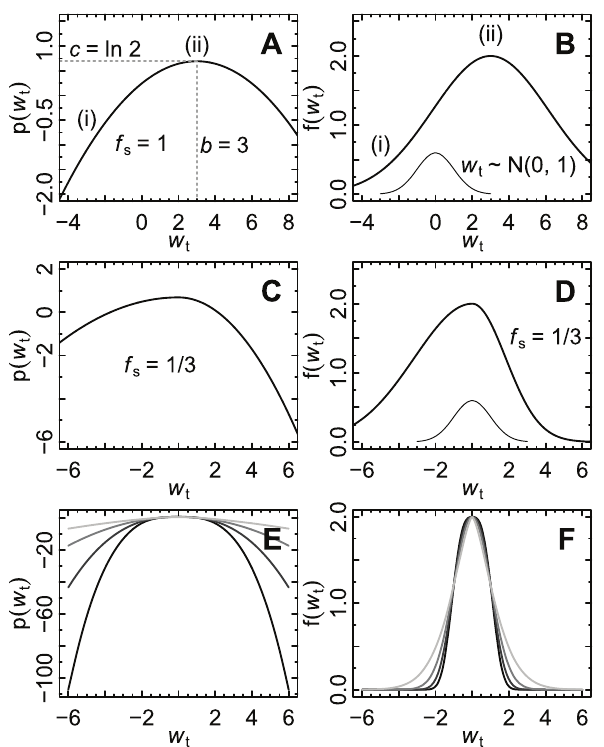
Figure 1. Example log and linear response functions. In the model considered, the response function is the relationship l t ~ f ( w t ) between the net growth rate, l t , at time t , and the environment, w t , at time t . In this figure, we indicate the flexibility of our parameterization of f (see main text for details). A log response function p ( w t ) (A) and corresponding linear-scale response function f ( w t ) (B) for a ~ 2 , a 1 ~ a 2 ~{ 0 : 05 , b ~ 3 , and c ~ ln2 . Region (i) represents a suboptimal environment and region (ii) represents an optimal environment. An example is also shown for an asymmetric response function with f s ~ 1 = 3 ( a 1 ~{ 0 : 05 , a 2 ~{ 0 : 15 ) on the log (C) and linear (D) scales, for b ~ 0 , c ~ ln2 , and a ~ 2 . Standard normal distributions (B, D) represent the population’s local environment w t . In B, the population is in a suboptimal environment, for instance at the periphery of the species’ range. In D the population is close to its ideal environment. Response functions on the linear (E) and log (F) scales for different values of a , ranging from a ~ 1 : 5 for the light grey, to a ~ 3 for the black line, for f s ~ 1 , and a 1 ~ a 2 ~{ 0 : 5 . The intermediate values of a are 2 and 2.5. value of w t at which f is maximized. The rate of falloff of p as w t decreases (respectively, increases) from the ideal environment is controlled by a 1 (respectively, a 2 ); both are taken to be negative. The ratio f s ~ a 1 = a 2 is a measure of asymmetry of the response function around b ; so a 1 and a 2 control the rate of falloff of the response function from the ideal environment and their relative magnitude controls symmetry. The functional form or general shape of the falloff is determined by a (Figure 1E, F); a is included as a variable (as opposed to a fixed value such as 2 ) for flexibility, so that response functions of a variety of shapes can be considered.